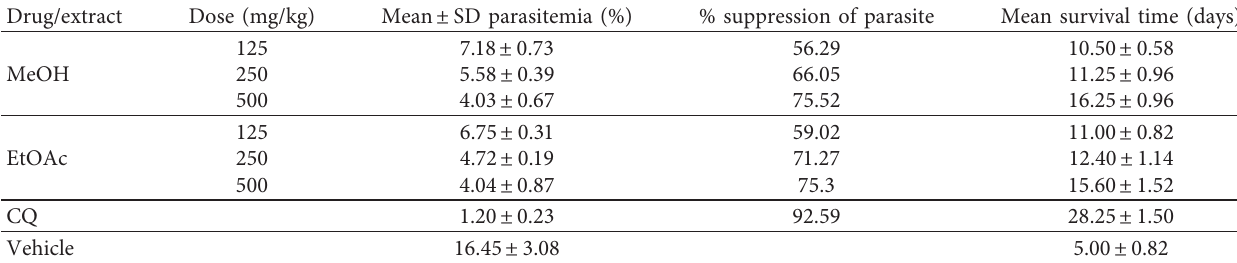
Table 4: Mean of parasitemia, % parasitemia suppression, and survival time after treatment termination.